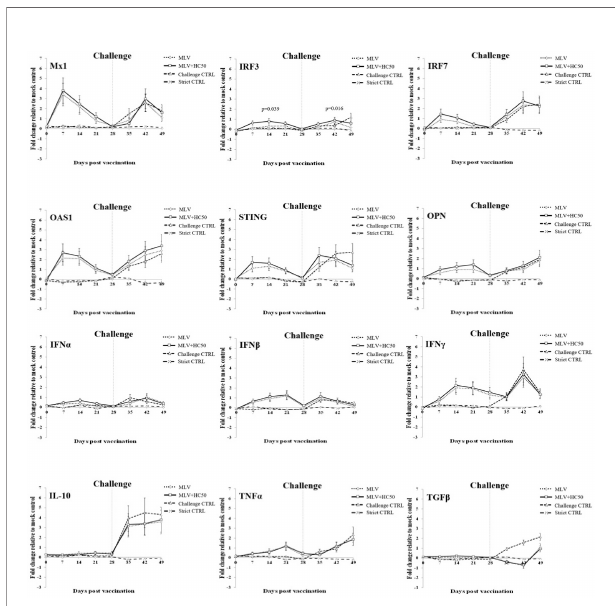
FIGURE 7 | Immune-related gene expressions in PBMCs re-stimulated ex vivo with HP-PRRSV-2. Pigs ( n = 6) were injected i.m. with Amervac ® PRRS MLV (0 dpv) (MLV) and Amervac ® PRRS MLV (0 dpv) and fed p.o. with HC50 (0 – 49 dpv) (MLV+HC50) or vaccine solvent used for resuspension of lyophilized Amervac ® PRRS MLV (0 dpv) (Challenge CTRL). The animals were challenged i.n. with HP-PRRSV-2 at 28 dpv (dotted vertical line). Strict control pigs